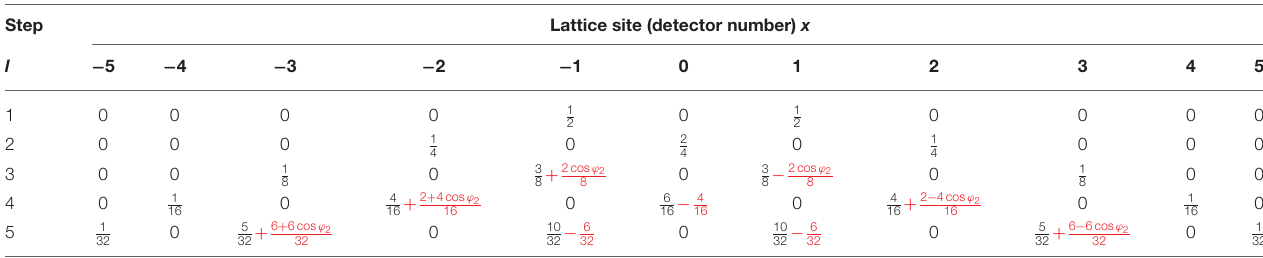
TABLE 1 | Quantum theoretical results for the probabilities of the quantum walk after l initially localized at x =